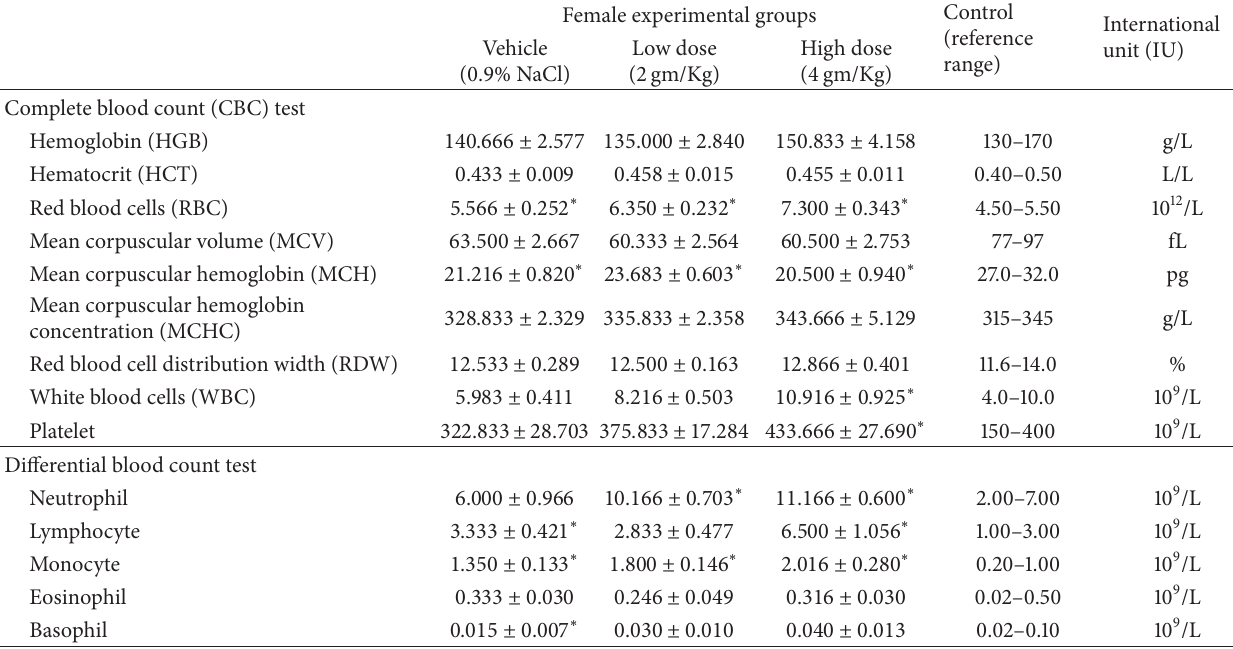
Table 6: Complete blood count and differential blood count tests among female